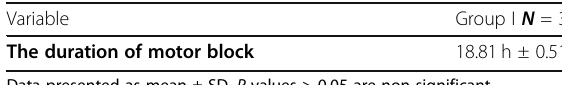
Table 6 The duration of motor block Variable